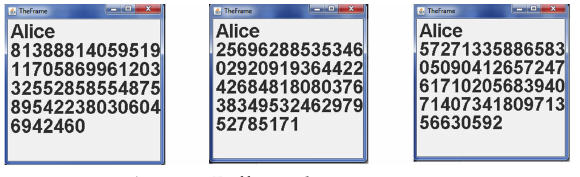
Figure 5: Di ff erent login